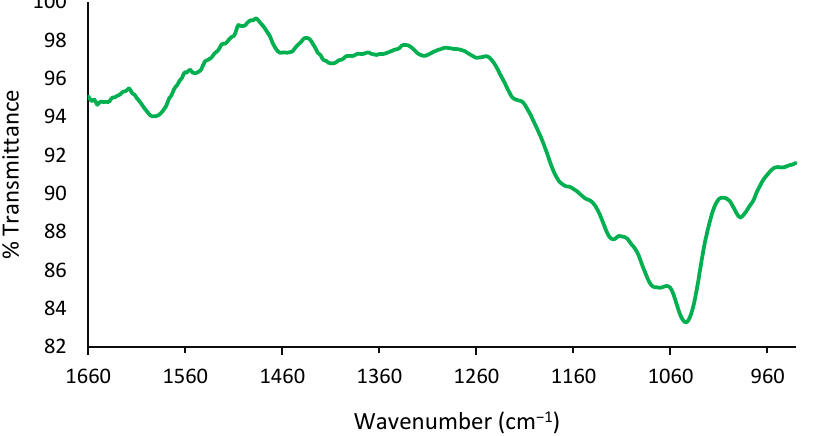
Figure 2. Amide I transmittance band at 1650 cm − 1 and amide II transmittance band at 1550 cm − 1 are observed. Aromatic ring stretching vibrations of C=C-C are observed at 1455 cm − 1 .